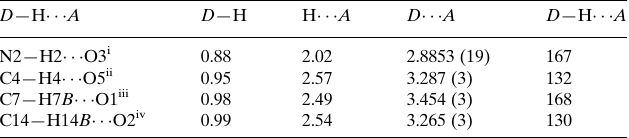
Hydrogen-bond geometry (A˚ , (cid:2)